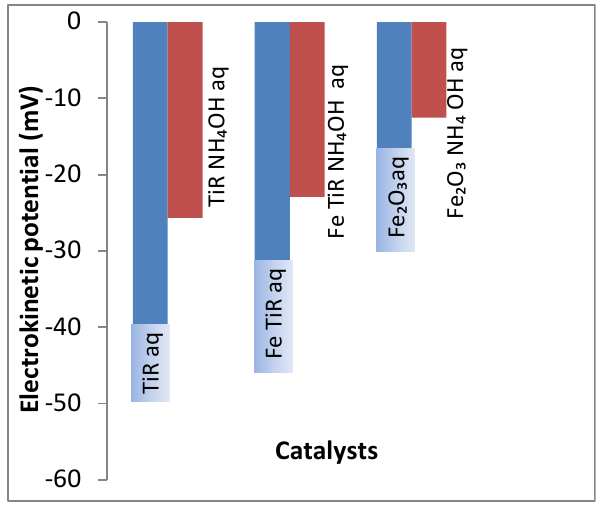
Figure 7. The electrokinetic potential of TiRs, Fe-modified TiRs and Fe 2 O 3 cubes suspended in deionised water and diluted ammonia solution.